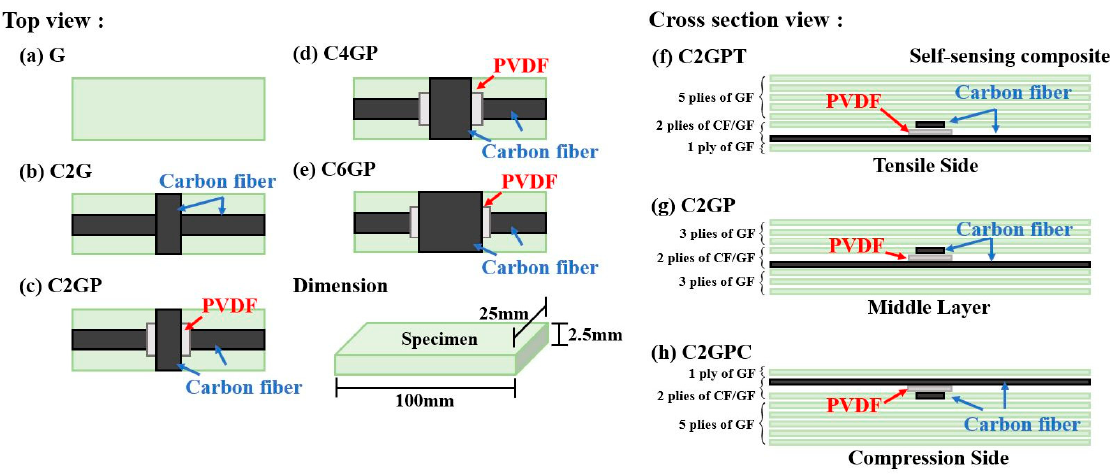
Figure 2. Schematic of different specimen types: ( a ) G; ( b ) C2G; ( c ) C2GP; ( d ) C4GP; ( e ) C6GP; ( f ) tensile-side membrane placement; ( g ) middle layer membrane placement; ( h ) compression-side membrane placement.